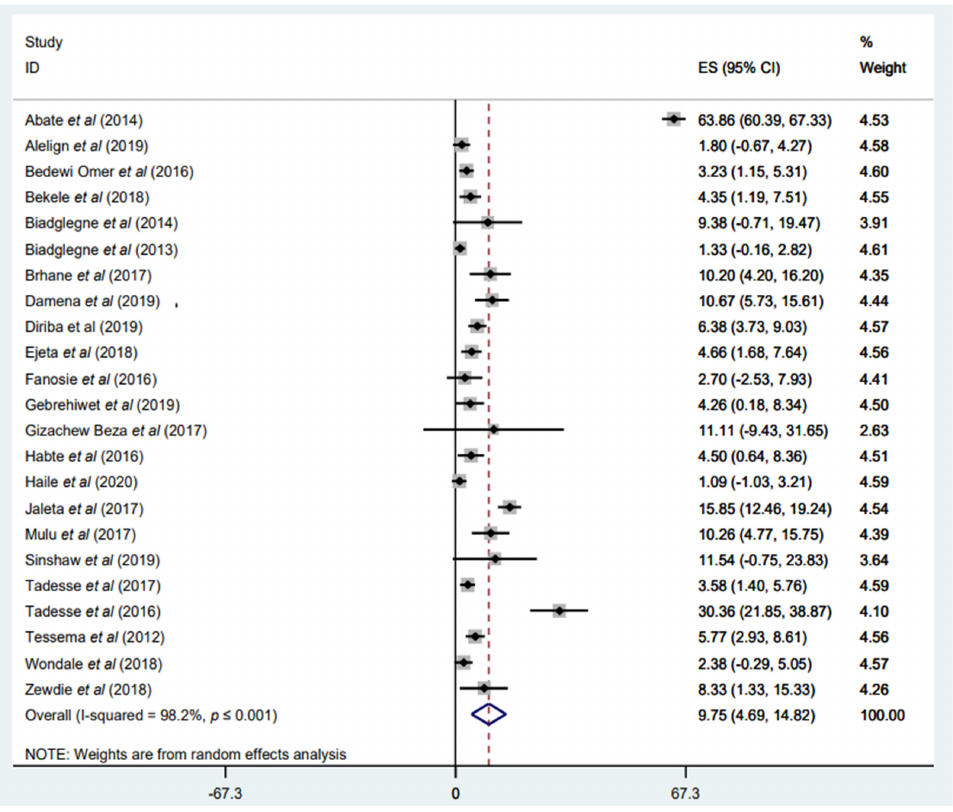
Figure 4. Forest plot showing the weighted pooled prevalence of any rifampicin (RIF) resistance in tuberculosis (TB) patients.